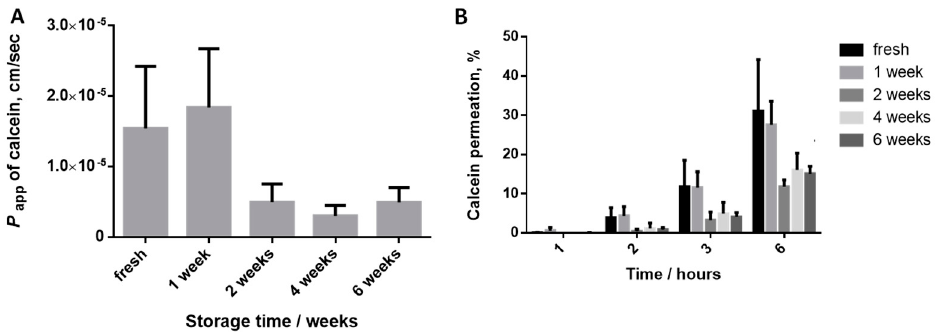
Figure 5. Effect of the drying time of the isolated SC on the permeability of calcein. ( A ) Apparent permeability coefficient at 3 h; ( B ) Percentage of permeation of calcein at different timepoints. Error bars represent the mean ± SD for at least three independent experiments. p < 0.05 for Kruskal-Wallis test among the storage